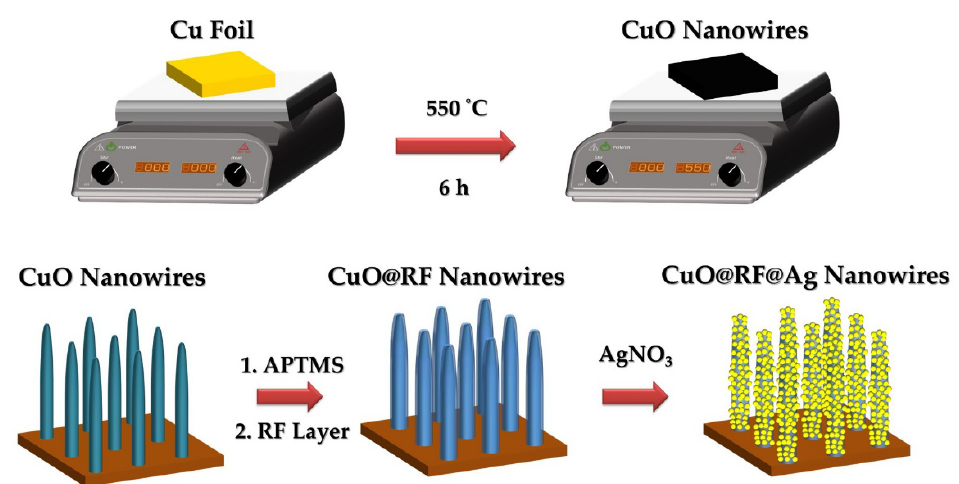
Figure 1. Schematic diagram of the preparation process for CuO@RF@Ag nanowires.